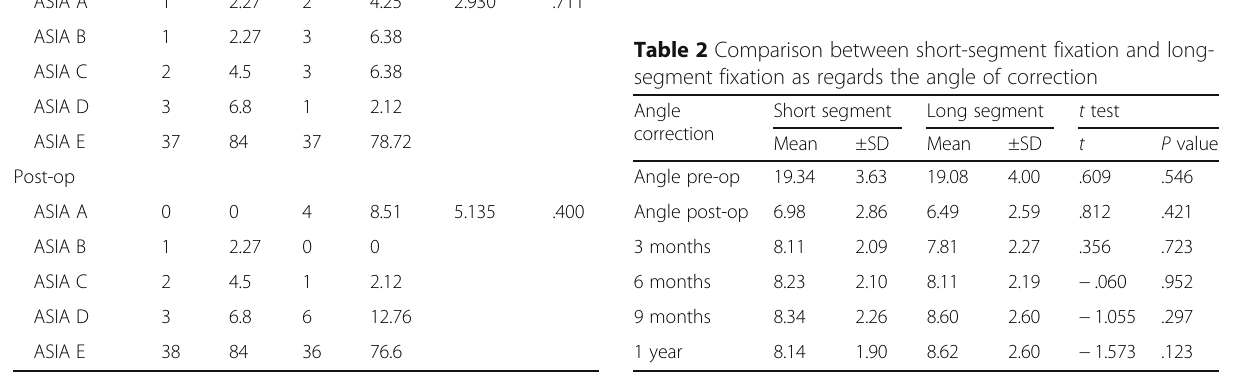
Table 1 Comparison between short-segment fixation and long- segment fixation as regards neurological status Neurological Short Long Chi-square test status